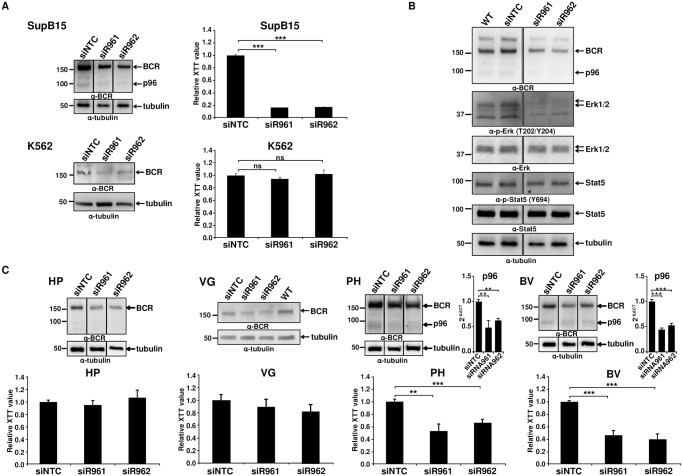
Targeting p96ABL/BCR in Ph+ ALL cells.(A) SupB15 and K562 cells were lentivirally transduced with shRNA against p96ABL/BCR (siR961 and siR962) and a control shRNA (NTC). The expression of p96ABL/BCR and/or BCR was detected by immunoblotting using anti-BCR antibody. Tubulin was used as loading control. Proliferation was measured using XTT-assay after 3 days. One representative experiment in triplicates ± SD of at least three yielding similar results is given; (B) The effect of targeting p96ABL/BCR by shRNA in SupB15 on STAT5 and ERK1/2 pathway was detected using the indicated antibodies; (C) Down-regulation of p96ABL/BCR in Ph+ ALL PD-LTCs by shRNA. Ph+ ALL PD-LTCs—PH: fully TKI-responsive; BV: TKI-resistant; as controls were used: HP (Ph- ALL patient) and VG: t(12;9)-TEL/ABL-positive ALL. The effect of shRNAs on the expression of p96ABL/BCR was tested by immunoblotting using the indicated antibodies and by q-RT-PCR for PH and BV. The Ct values were normalized to that of GAPDH and results are represented as 2-ΔΔCt. Proliferation was measured by XTT-assay. The mean of at least experiments is given ± SD.